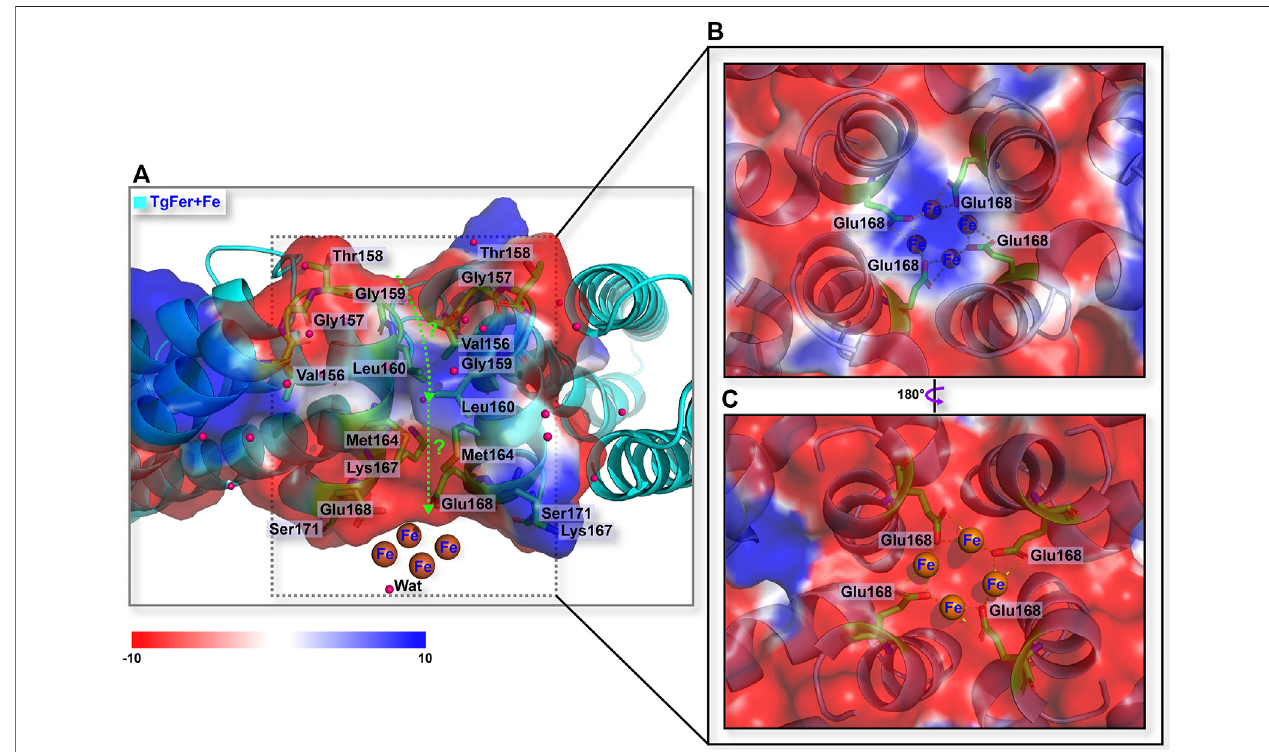
FIGURE6|(A) Schematicoverviewofthe4-foldchannelofTgFer+Fe. (B) Thedetailedcoordinationenvironmentforironionsviewedfromtheoutsideofthe4-fold channel in TgFer + Fe. (C) The detailed coordination environment for iron ions from the inside view of the 4-fold channel in TgFer + Fe. The pink sphere represents water